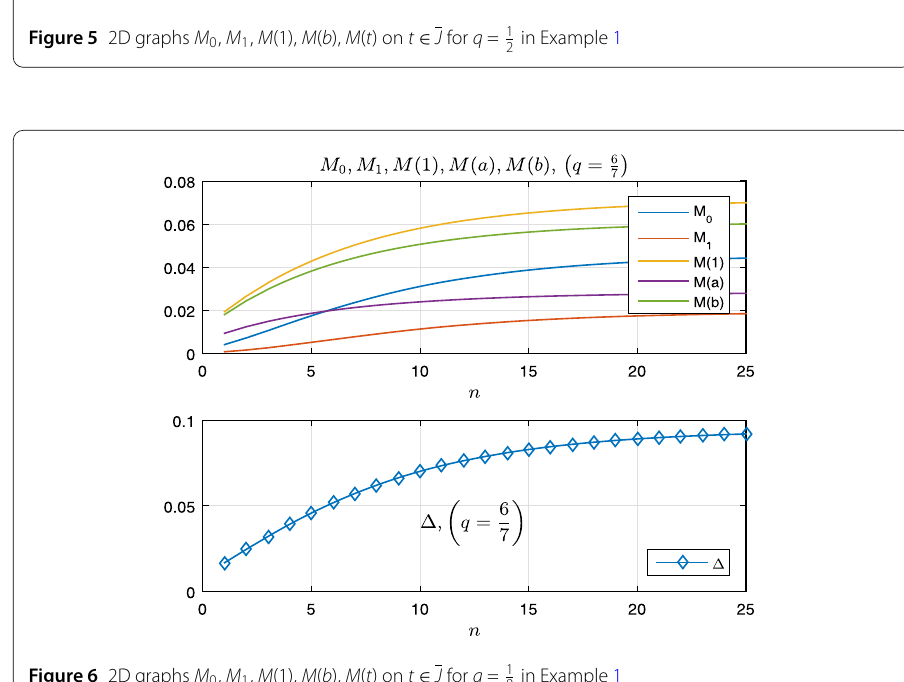
Figure 6 2D graphs M 0 , M 1 , M (1), M ( b ), M ( t ) on t ∈ J for q = 1